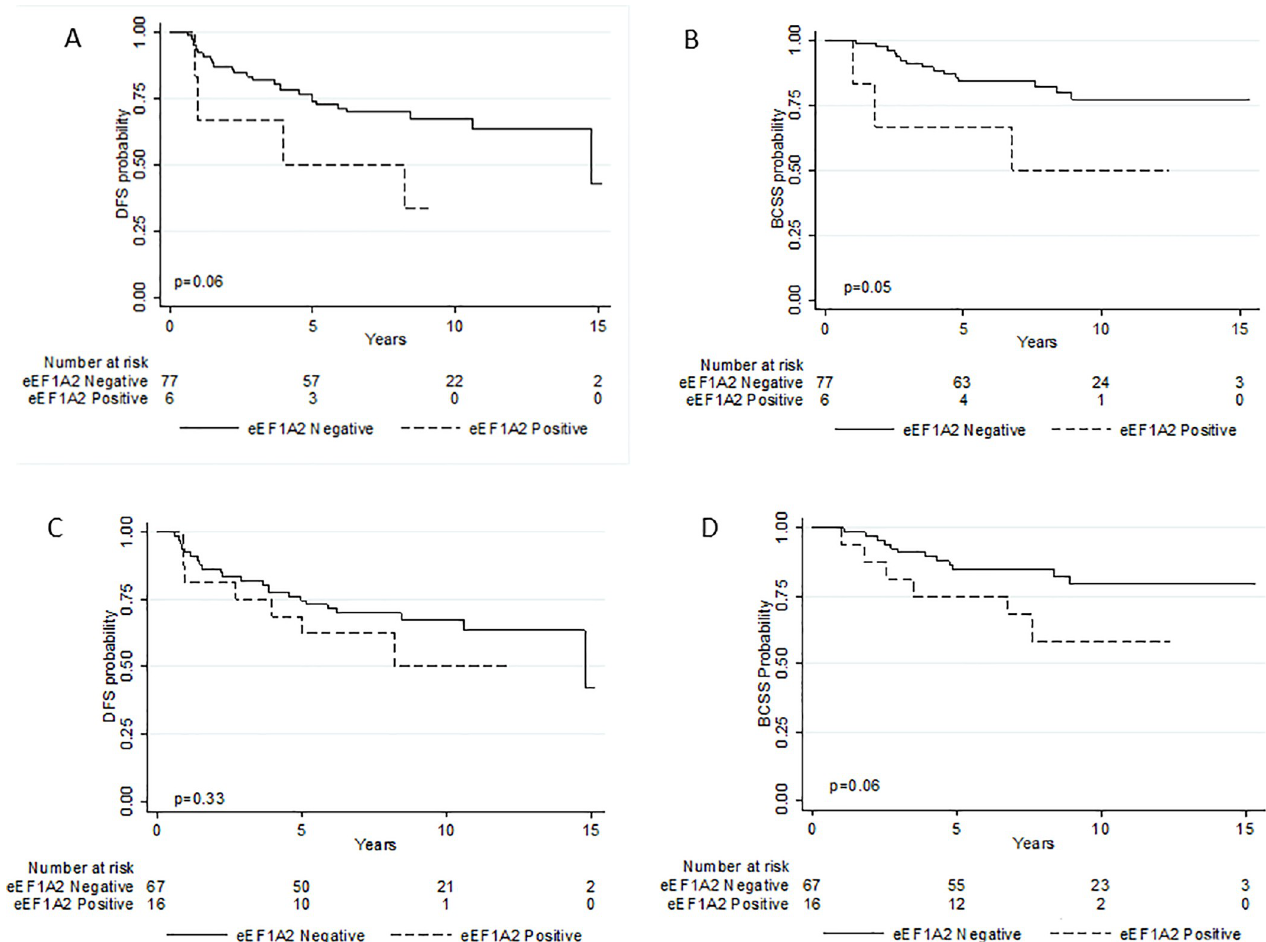
Fig 5. Estimated disease-free survival (A-C) and breast cancer specific survival (B-D) according to eEF1A2 dichotomizations . In panels A and B, a patient is considered eEF1A2 negative if the sum of the percentage of cells staining absent [0] and of the percentage of cells staining weakly [1+] is greater than the sum of the percentage of cells staining moderately [2+] and strongly [3+]; in panels C and D, a patient was considered eEF1A2 negative if it had no expression of eEF1A2 (100% expression at 0 or 1+), and positive otherwise.